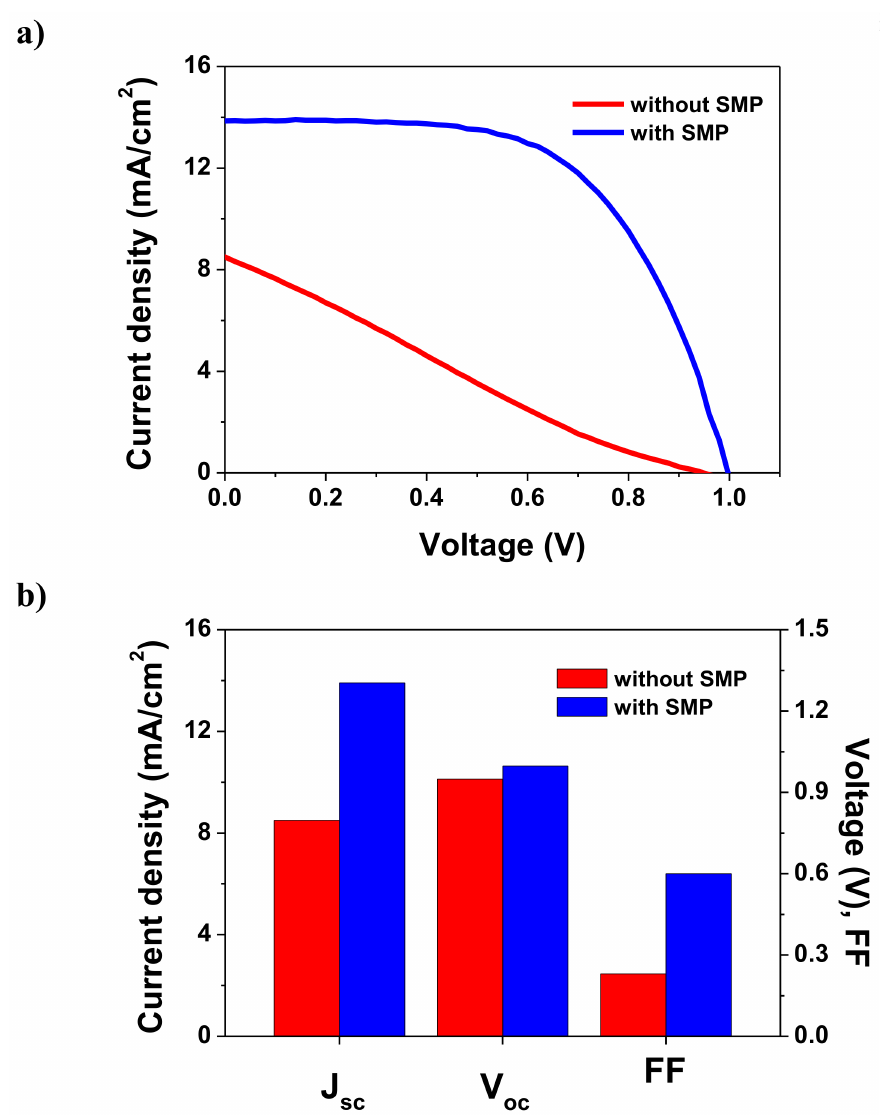
Figure 5. ( a ) Current–voltage curves and ( b ) current density (J sc ), open-circuit voltage (V oc ), and fill factor (FF) values of perovskite solar cells based on mesoporous TiO 2 sintered at a low temperature, with and without the surface modification process